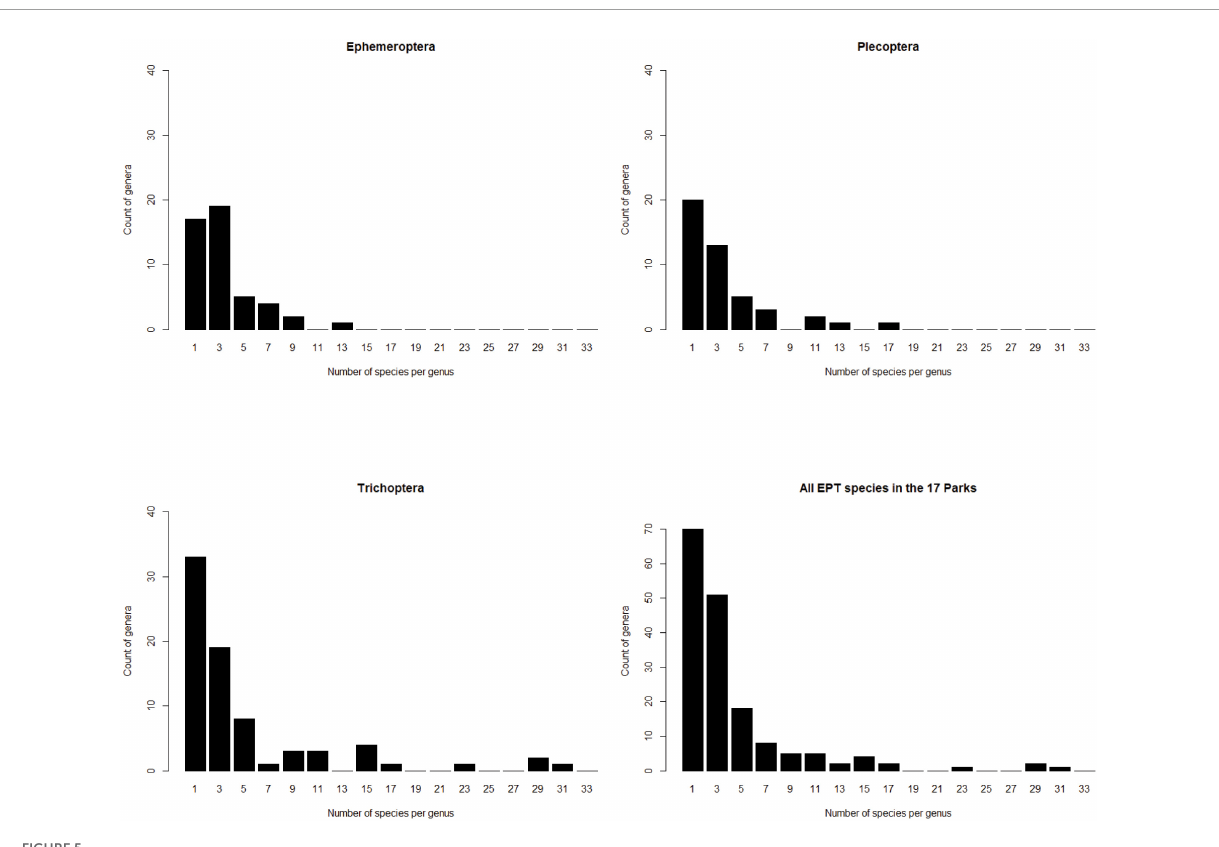
(Forbes, 1887). On this view, higher phylogenetic groupings of aquatic insect species are essentially “packages” of shared (phylogenetic conserved) traits that are inherited